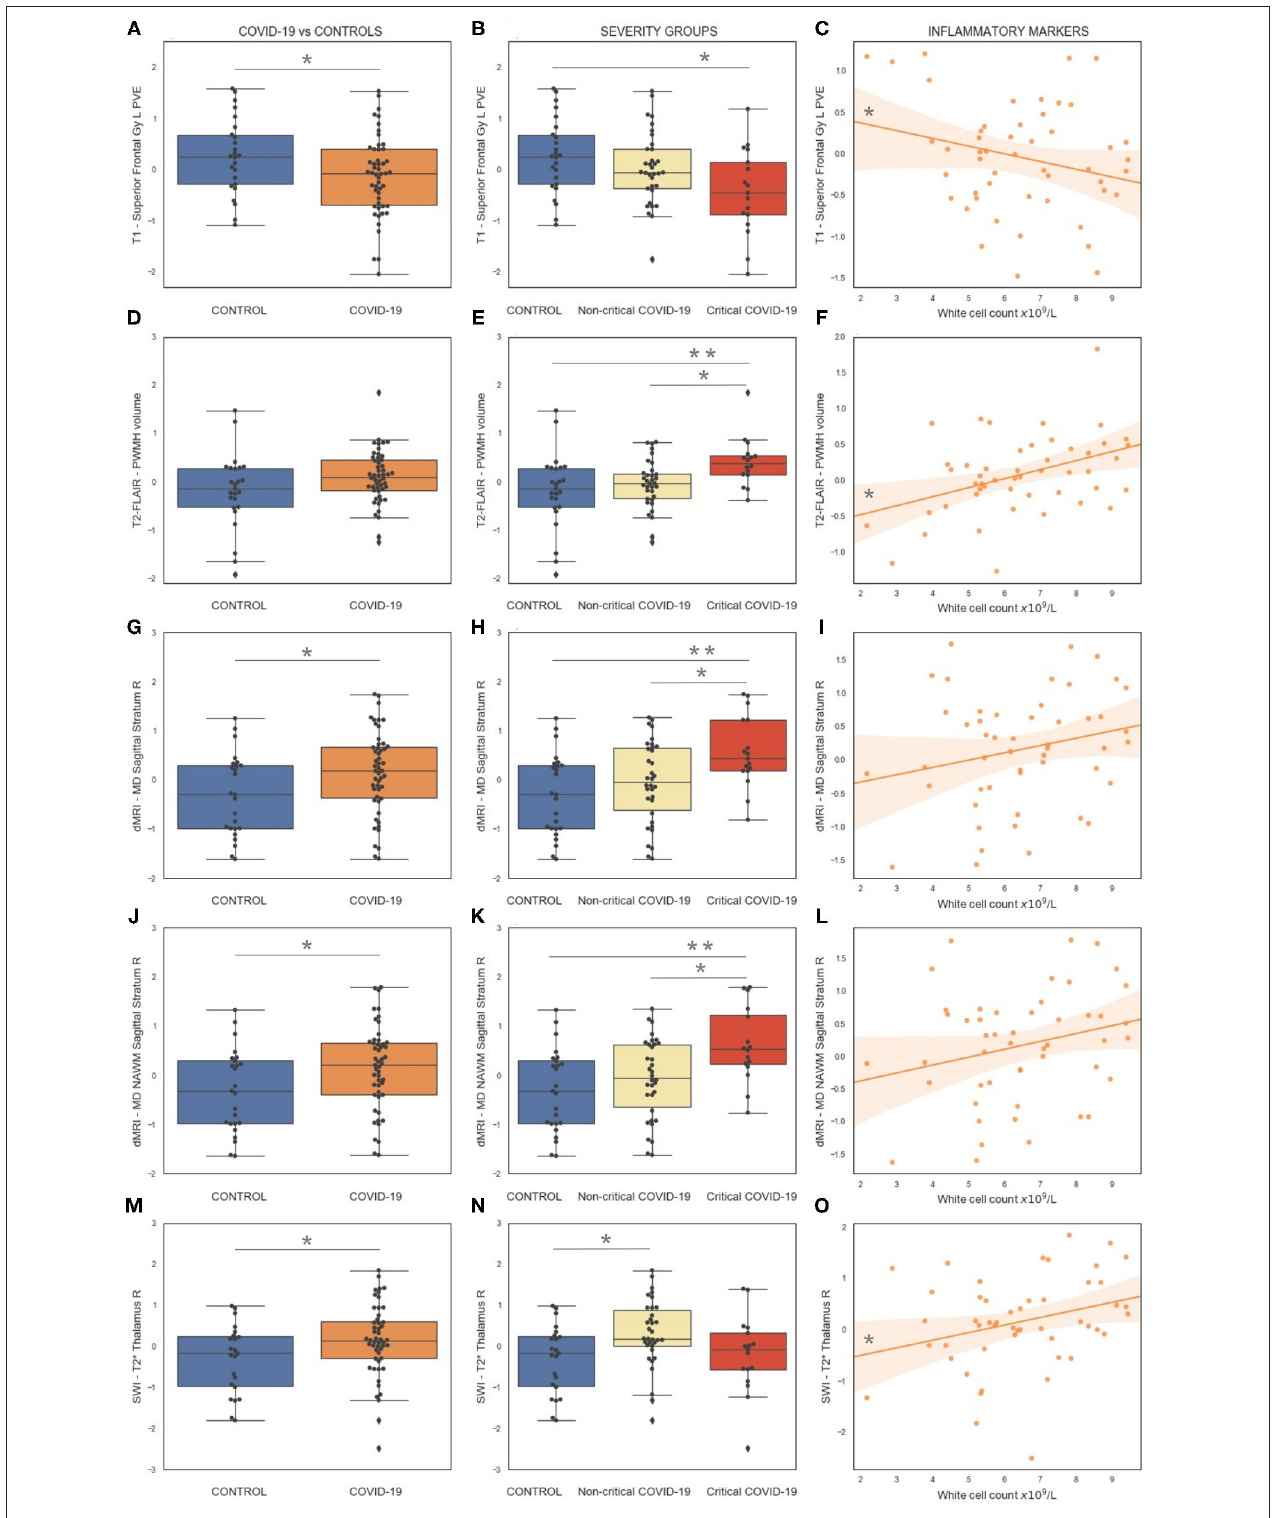
FIGURE 3 | Representative results of the exploratory analyses on multimodal brain MRI-derived IDPs from the C-MORE study. The first column (A,D,G,J,M) shows the comparison between COVID-19 patients and controls. The middle column (B,E,H,K,N) shows the comparison across severity groups. The right column (C,F,I,L,O) shows the relationship between IDPs and inflammatory markers (white cell count) in COVID-19 survivors. All IDPs were Gaussianised and deconfounded. * p (uncorr) < 0.05, ** p (uncorr) < 0.01. See Supplementary Material for more